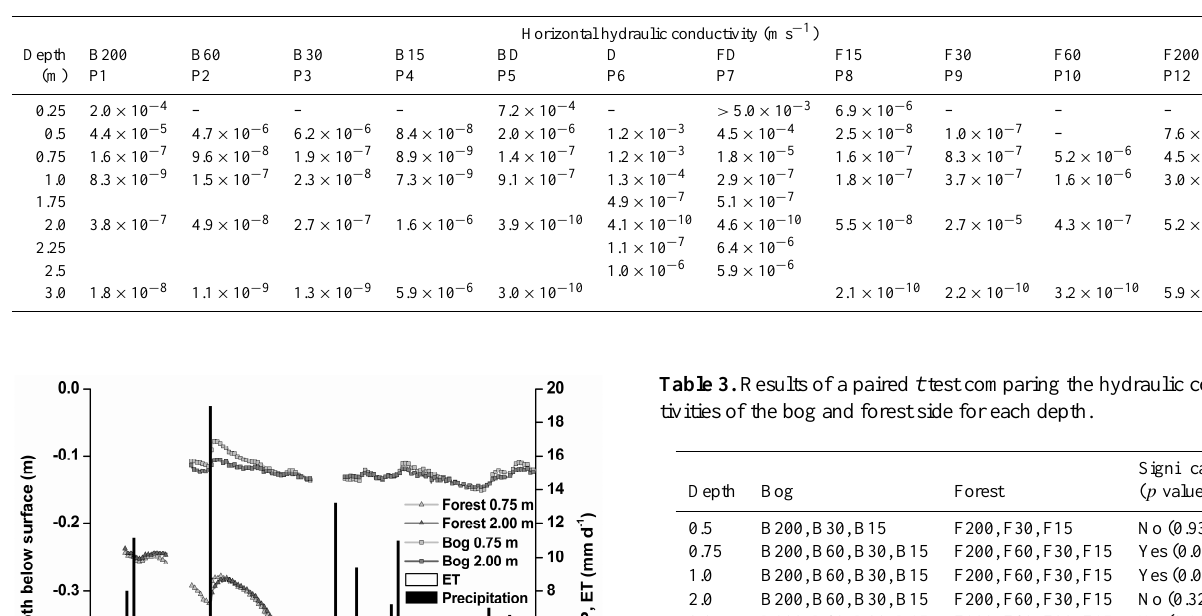
Table 2. Estimates of the horizontal hydraulic conductivities across the transect determined by slug tests after Hvorslev (1951).